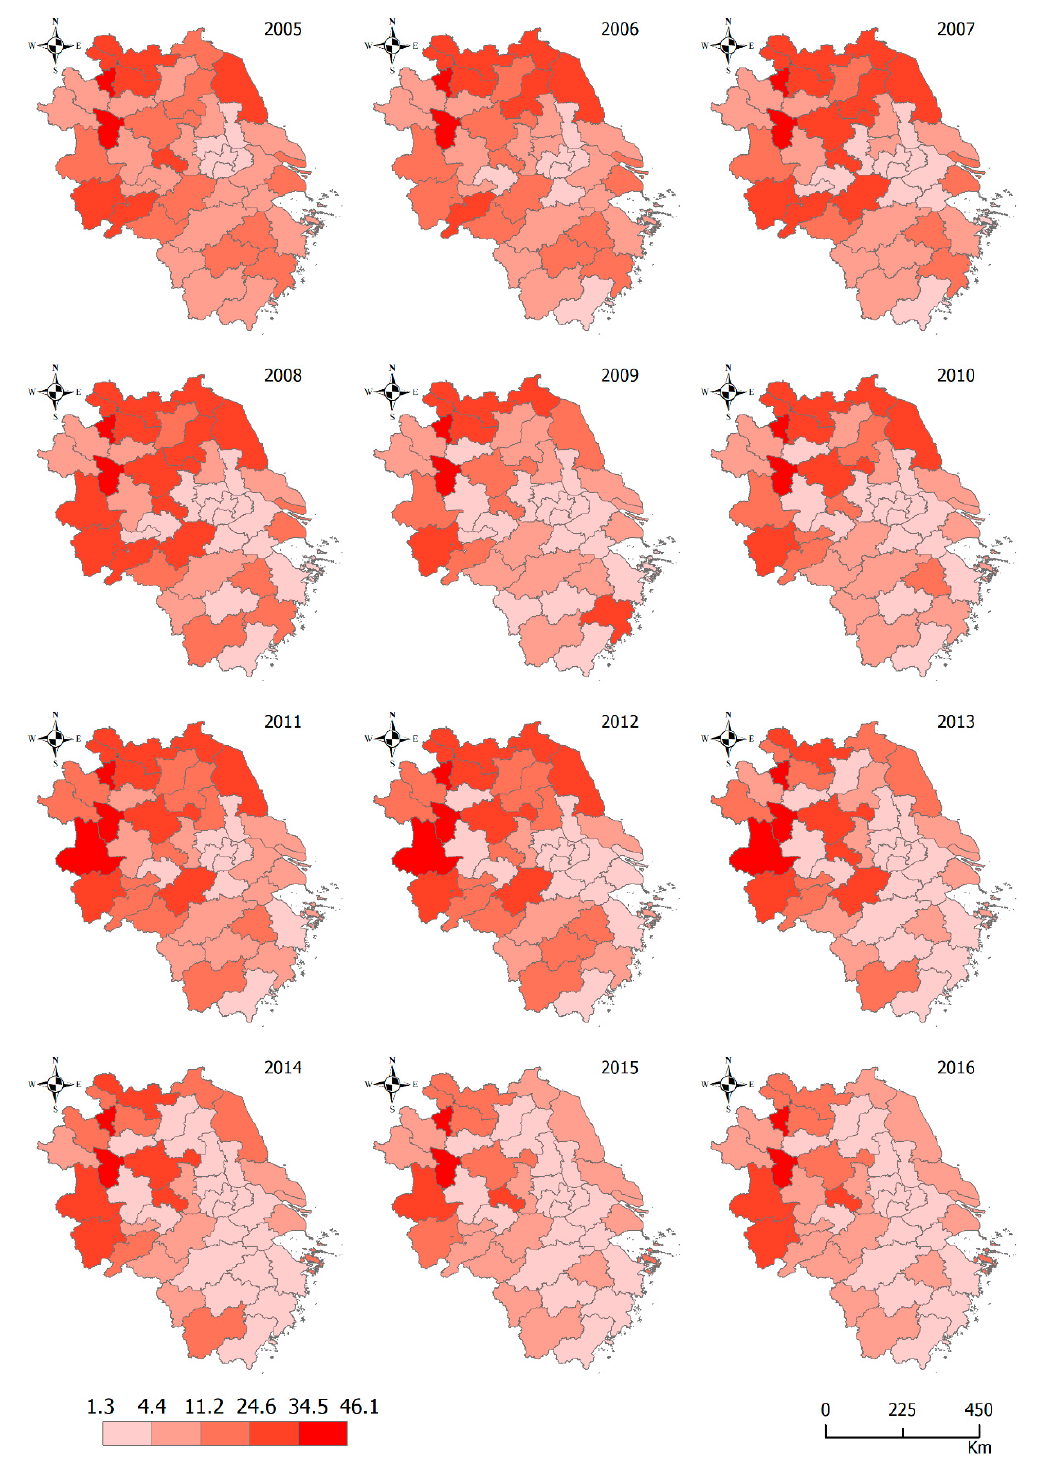
Figure 4. Spatiotemporal distribution of MAR.